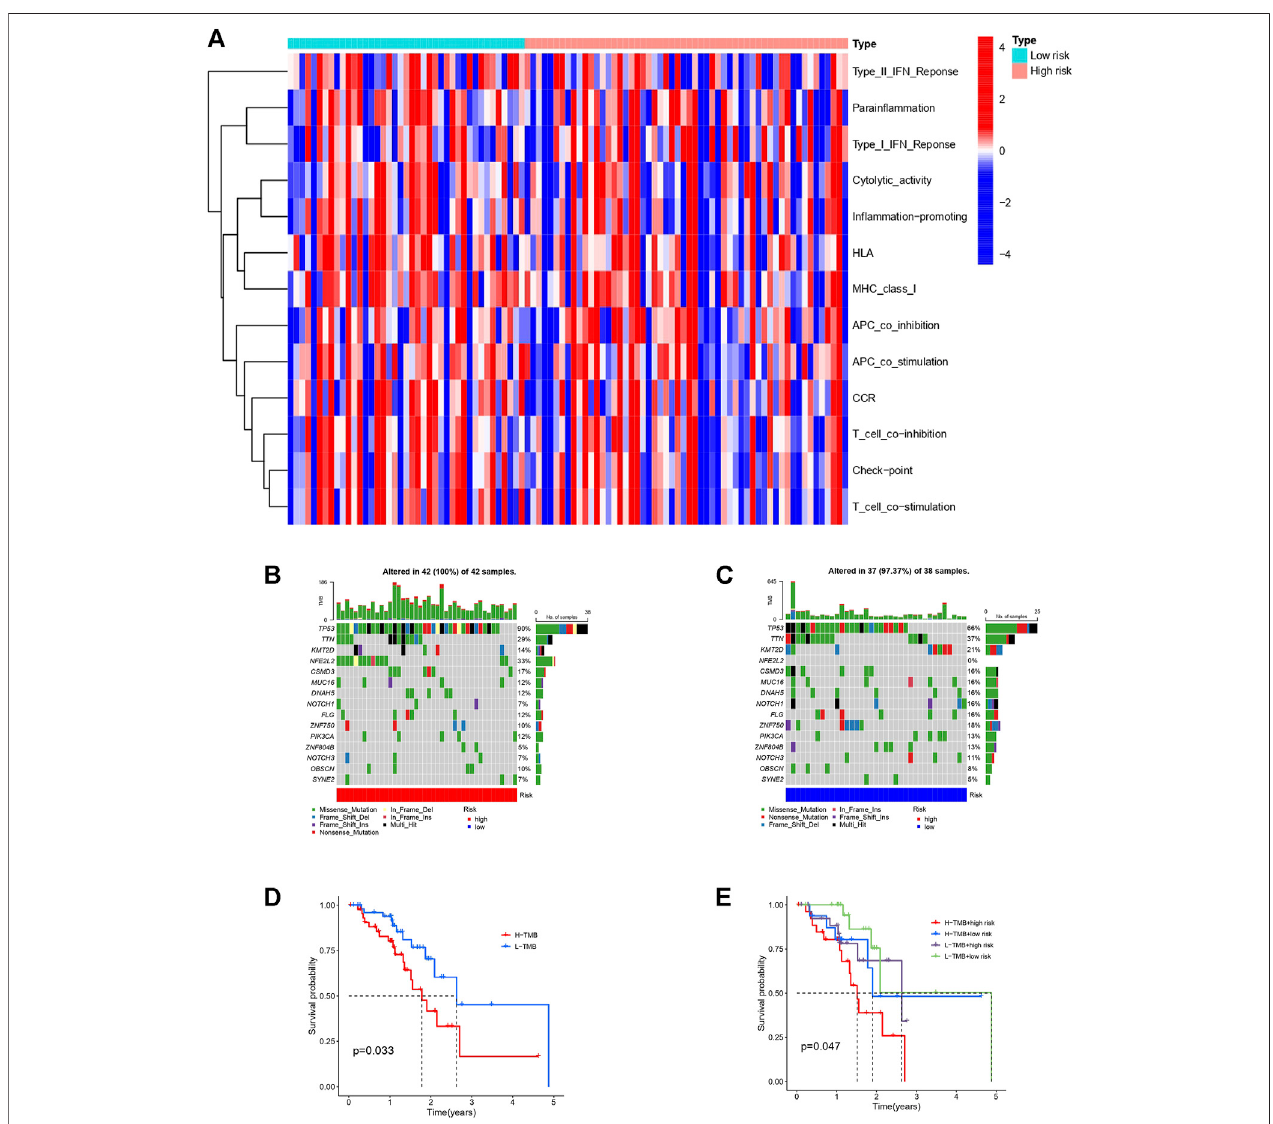
FIGURE 7 | Immune function heatmap and TMB in high and low risk groups of patients with ESCC. (A) : Heatmap of immune functions of the two risk groups. (B) : Waterfall plot of TMB in high-risk group. (C) : Waterfall plot of TMB in low-risk group. (D) : Survival curves of patients with ESCC divided into high or low-TMB groups. (E) : Survival curves of patients with different TMB based on high or low risk classi fi cation.